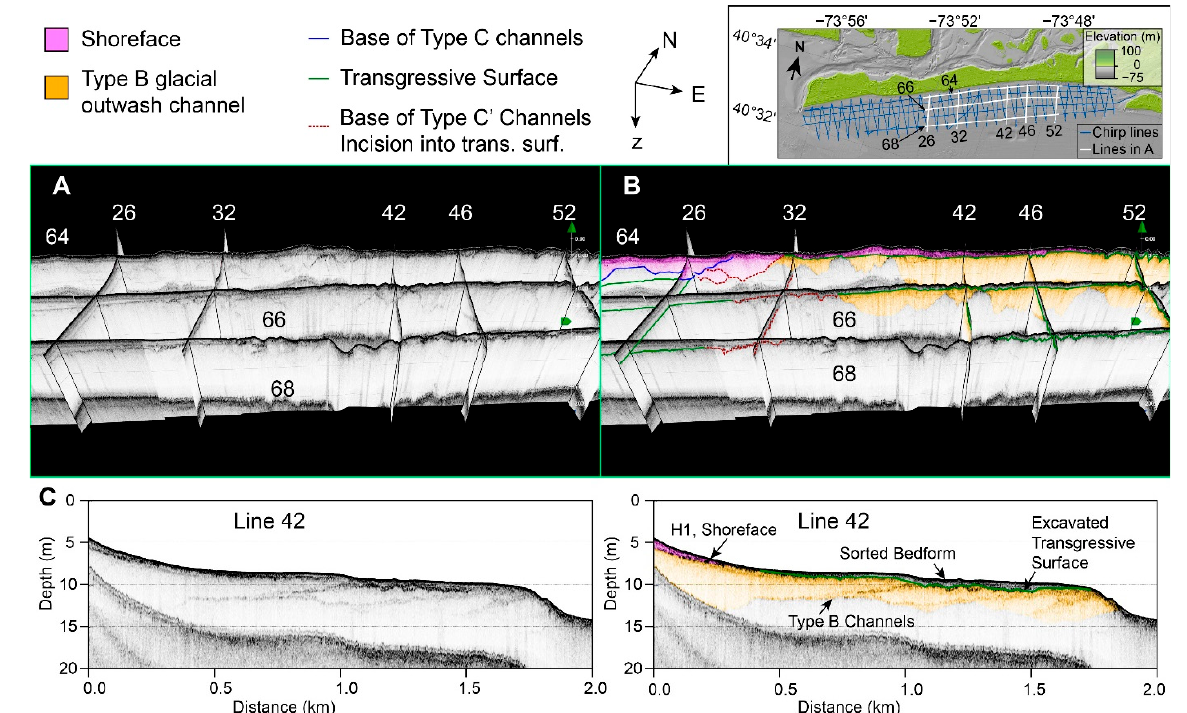
Figure 11. ( A , B ) Uninterpreted and interpreted seismic fence diagrams show relationships between the shoreface, the transgressive surface, and underlying Type B, C, and C’ channels. Colors are explained in upper left. Location of lines shown in the fence diagrams are shown in the upper right. ( C ) Uninterpreted and interpreted profiles of dip profile 42 highlight extensive Type B channels and areas where the transgressive surface is excavated by a sorted bedform.